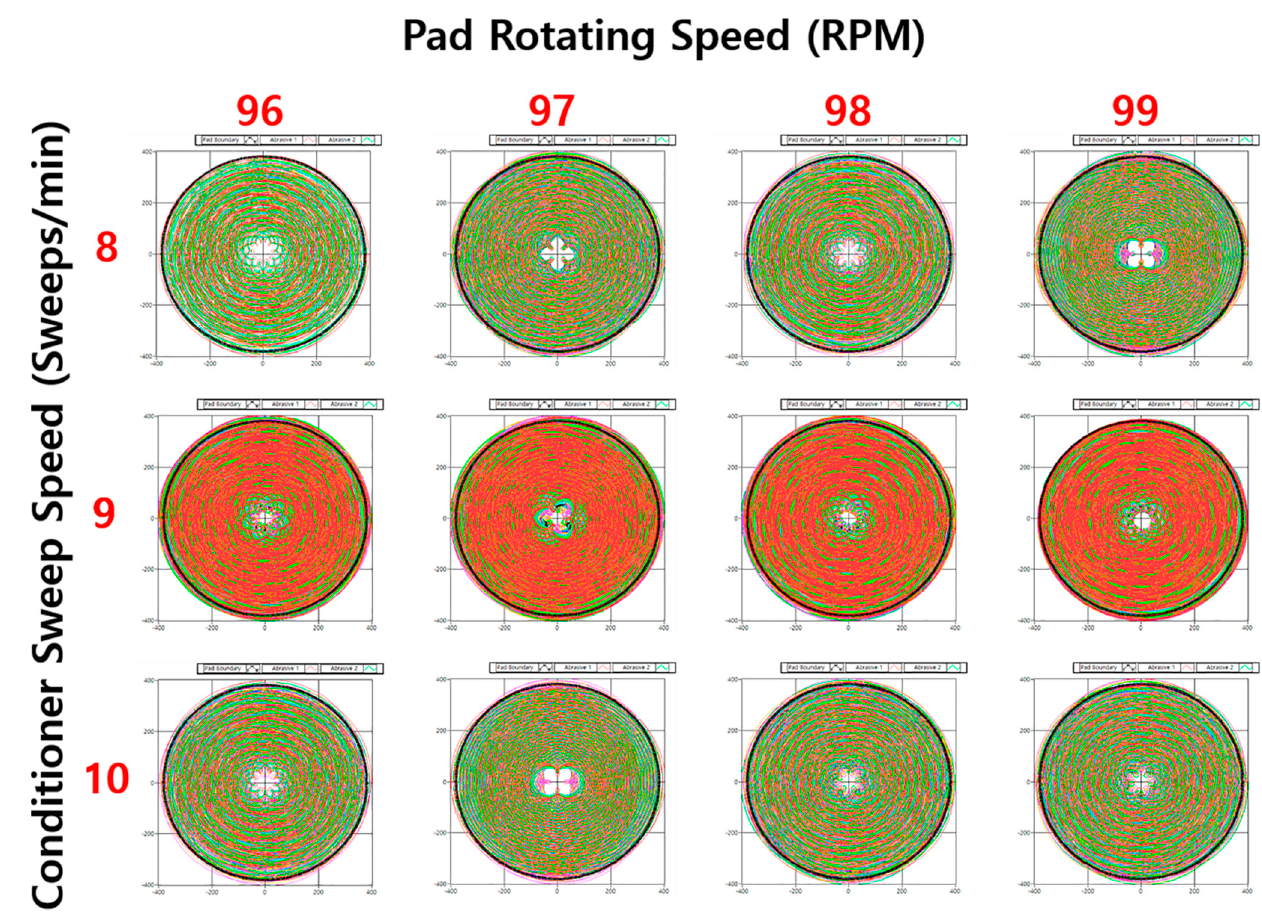
Figure 7. Trajectory of working diamond abrasives on the pad with respect to the pad rotation speed and conditioning arm swing speed.